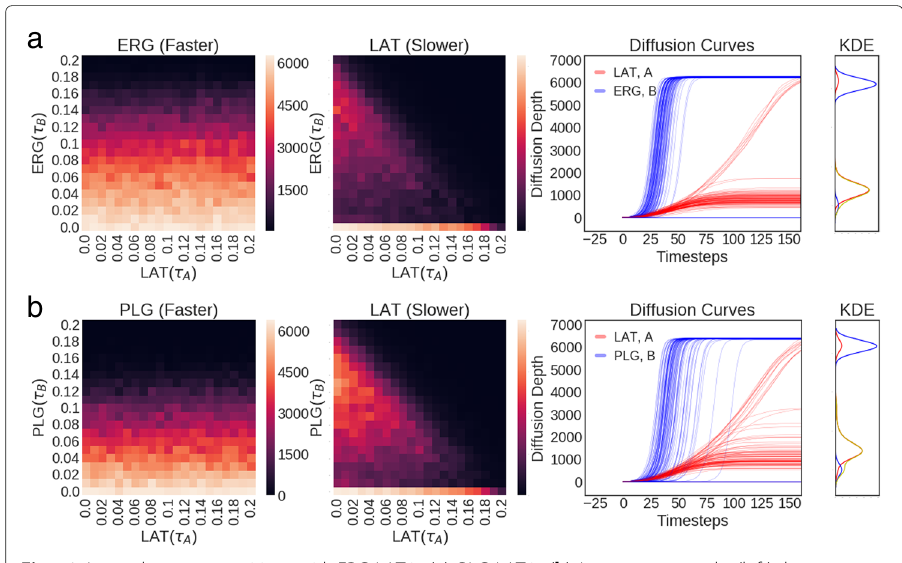
Fig. 10 Long-short range pairings with ERG-LAT in ( a ), PLG-LAT in ( b ). Long-range graphs (left) demonstrate vertical sensitivity and little sensitivity to the short-range dormancy. The lattice graphs show sensitivity to both dormancy values, and diffuses only when the constraint τ LAT > τ A is met, as shown by the diagonal. As the PLG and ERG graphs (left) transition to black vertically, the LAT layer (right) grows brighter (indicating gains in diffusion depth). We set α to